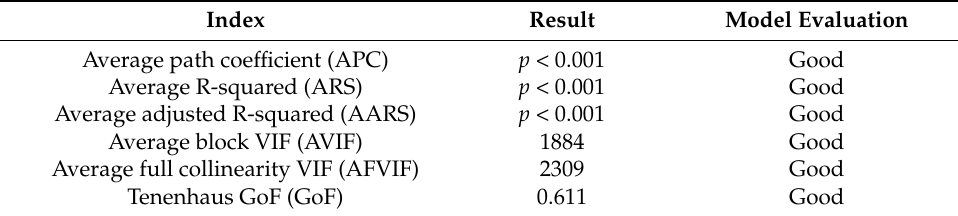
Table 3. Godness of